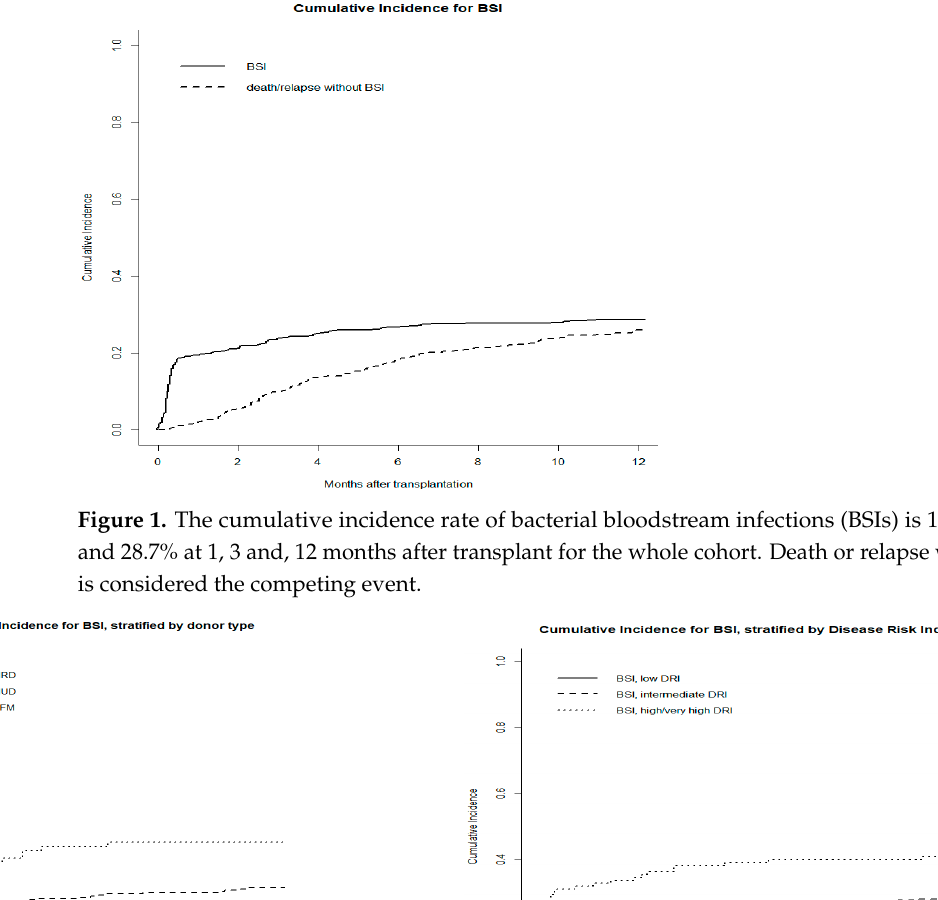
Figure 1. The cumulative incidence rate of bacterial bloodstream infections (BSIs) is 19.4%, 23.8%, and 28.7% at 1, 3 and, 12 months after transplant for the whole cohort. Death or relapse without BSIs is considered the competing event.